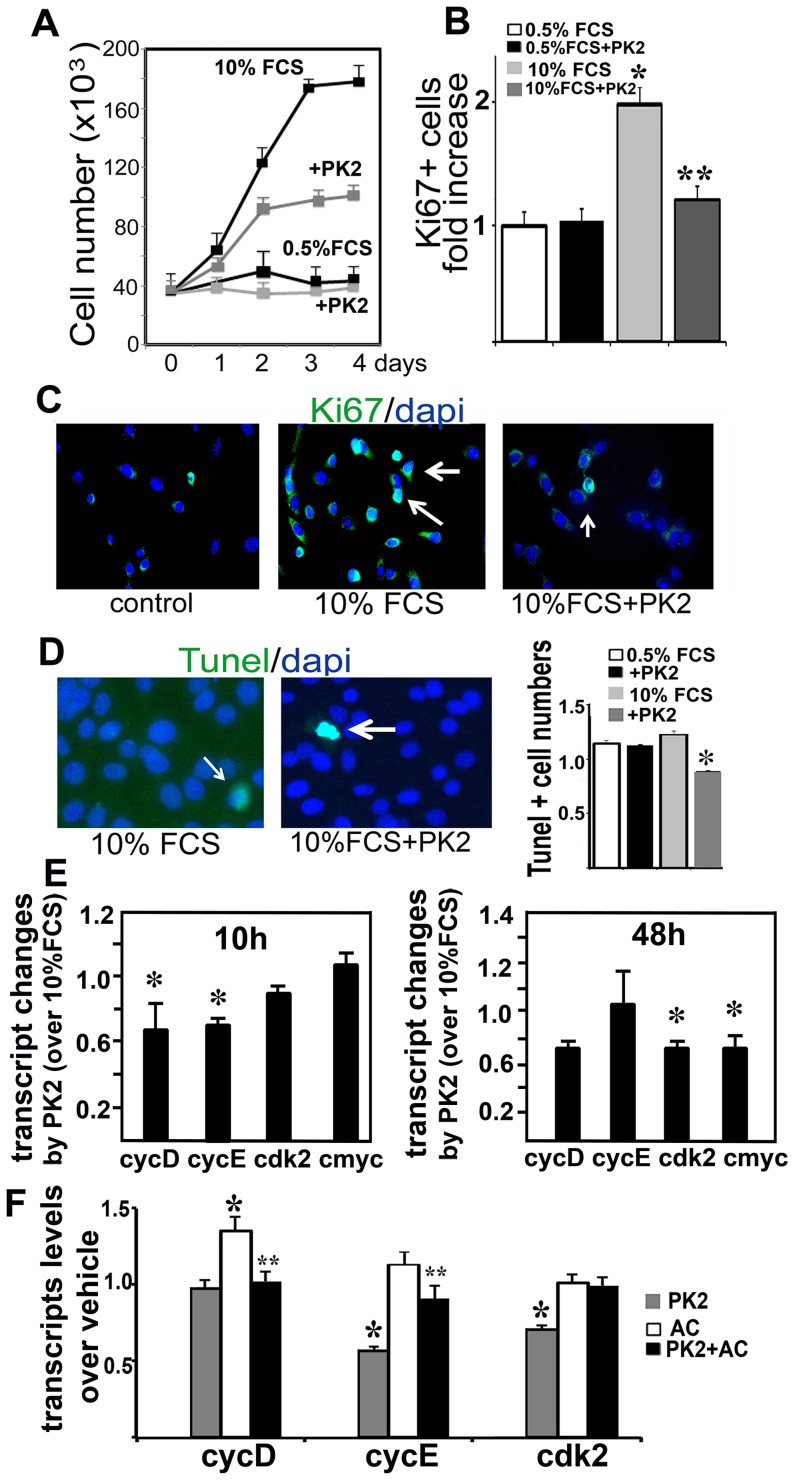
Prokineticin-2 inhibits proliferation of 3T3-L1 cells.A) 10% FCS increased cell numbers within 24 h as compare to cell numbers in 0.5% serum treated cells reaching to maximum within 4 days. Treatment of the cells with prokineticin-2 (5 nM) significantly reduced cell numbers as compare to that of 10% FCS alone. B) Ki67 positive proliferating cells in S phase were increased approximately 2 times with 10% FCS treatment of the 3T3-L1 cells (**p<0.05, n = 20). Pretreatment of the cells with prokineticin-2 completely abolished Ki67 positive cell number (*p<0.05, n = 4). C) Representative illustration of Ki67 positive cells (green) and dapi positive total cells (blue) in control (0.5%FCS), 10%FCS and PK2+10%FCS groups (HPF, ×40 objective). D) Representative illustration of Tunel positive cells (green) and dapi positive total cells (blue) in each group. No detectible apoptotic cells were observed in either group (n = 20, HPF, ×40 objective). E) qPCR analyses for cycling gene expression 10 hours (left) and 48 hours after 10% FCS and 10% FCS+Prokineticin-2 treatment. Transcript of Cyclin D and E levels (fold increase) were reduced 10 h after treatment of the prokineticin-2, whereas cdk2 and c-Myc were reduced 48 h after prokineticin-2 treatment (*p<0.05, n = 4) as compare to that of 10% FCS alone. F) Histogram shows quantification of transcript levels for cyclin E, D and cdk2 48 after adipogenic cocktail (AC) treatment following prokineticin pretreatment for 10 hours in 3T3-L1 cells as compare to that of vehicle (n = 5, * different from vehicle, ** different from AC, p<0.05).